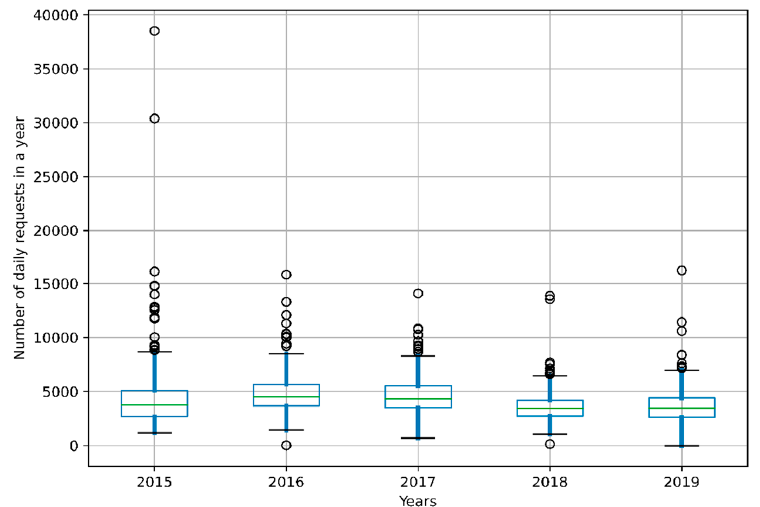
Figure 4. Daily request count of movies on the basis of Movie-ID for each year.